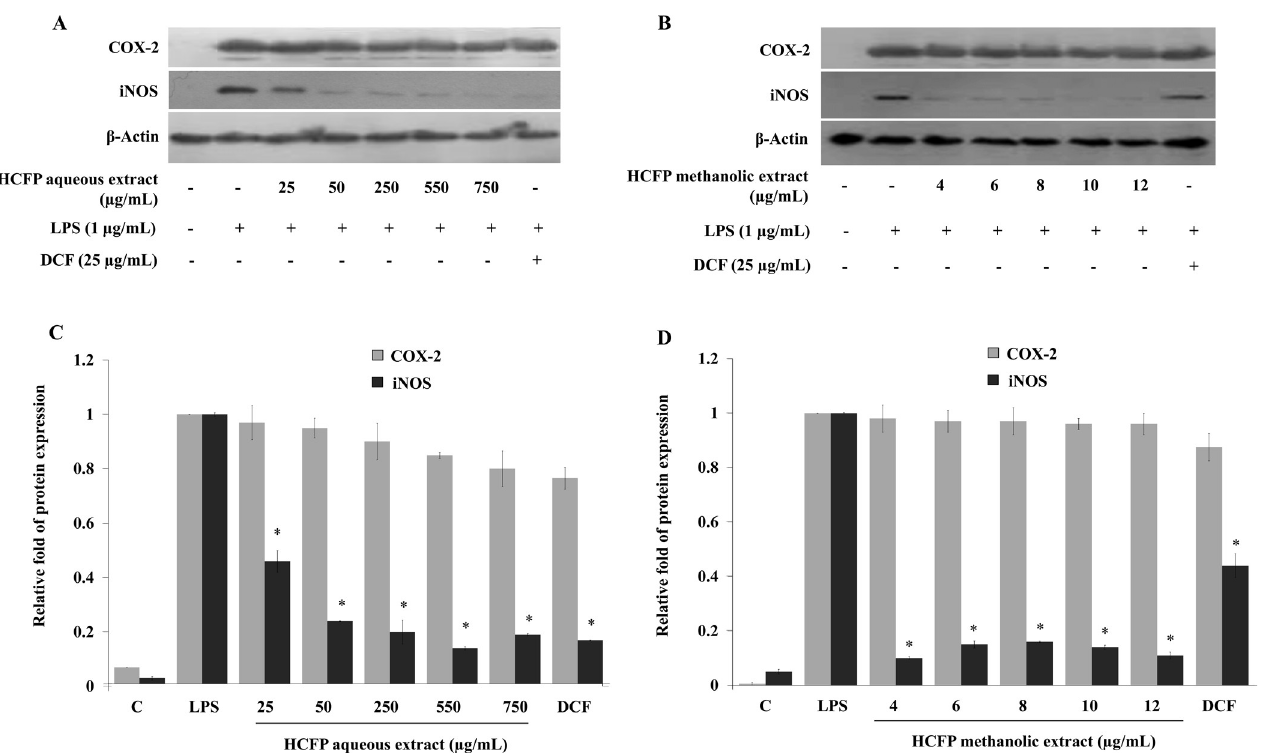
Fig 3. Effect of aqueous (A) and methanolic (B) extracts of HCFP on protein levels of iNOS and COX-2 in LPS-stimulated RAW264.7 cells. The cells were pre- treated with the indicated concentration of aqueous extract or phenolic extract for 2 h and then stimulated with LPS (1 μ g/mL) for 24 h. The protein expression levels were analyzed by western blot. Bar graphs showed the relative fold of protein expression in aqueous- (C) and methanolic- (D) treated cells. Data were expressed as mean ± S.D. � p < 0.05 compared with the LPS group.